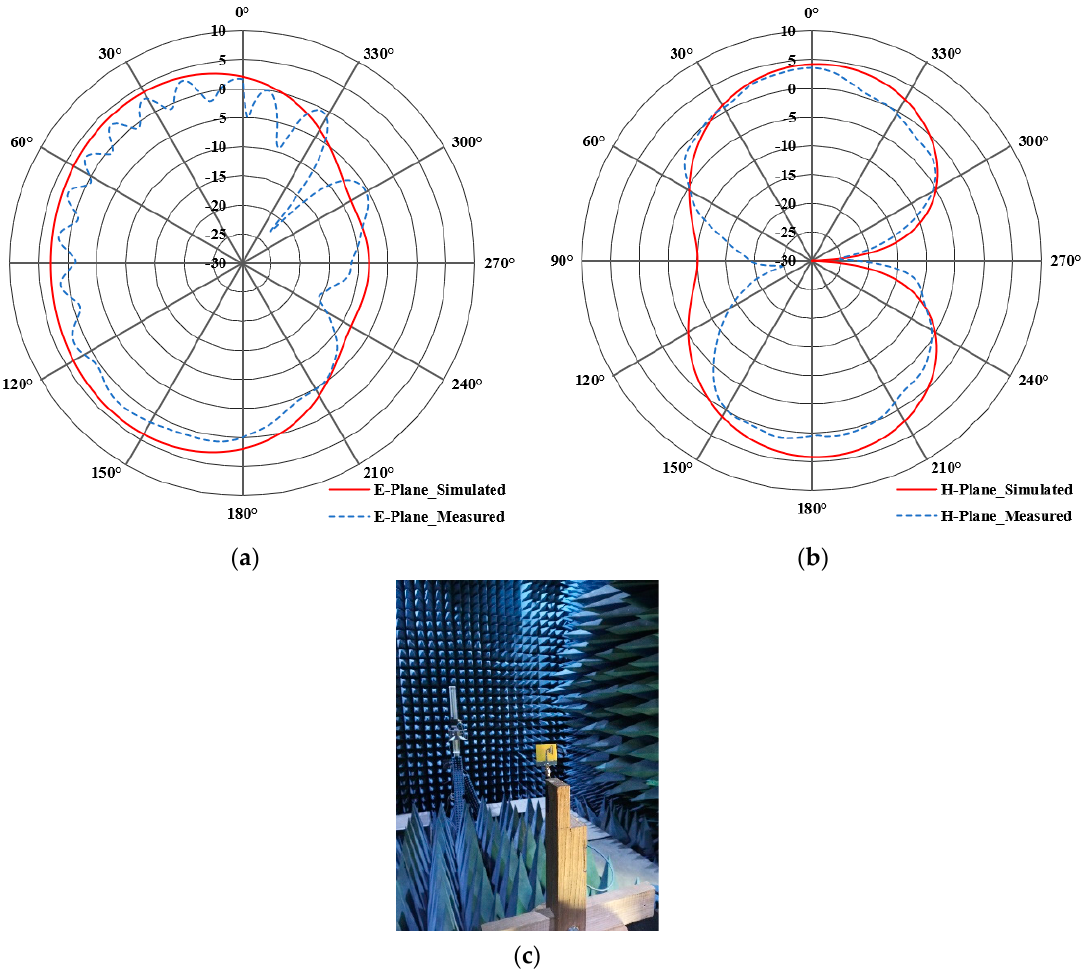
Figure 9. Simulated radiation pattern of the proposed antenna at 4.9 GHz: ( a ) E − Plane, ( b ) H − Plane, ( c ) radiation pattern measurement